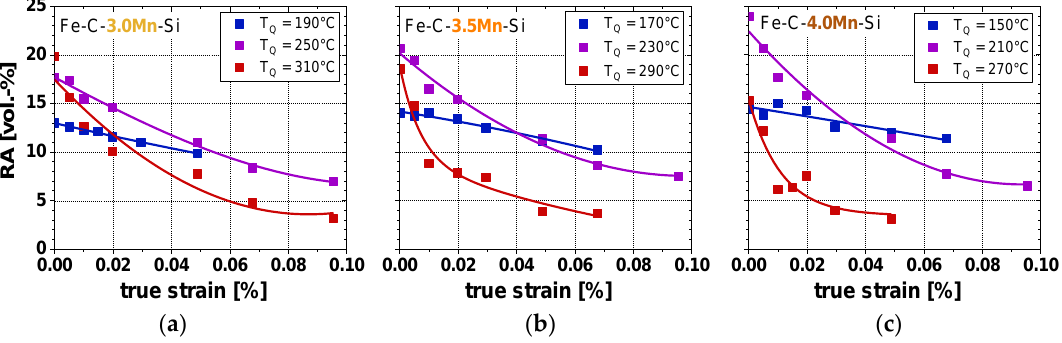
Figure 9. RA-content as a function of true strain obtained after interrupted tensile testing for the ( a ) Fe-C-3.0Mn-Si, ( b ) Fe-C-3.5Mn-Si and ( c ) Fe-C-4.0Mn-Si steels quenched to different T Q in order to adjust 50 vol.% (red), 75 vol.% (purple) and 85 vol.% ( blue) α’ prim